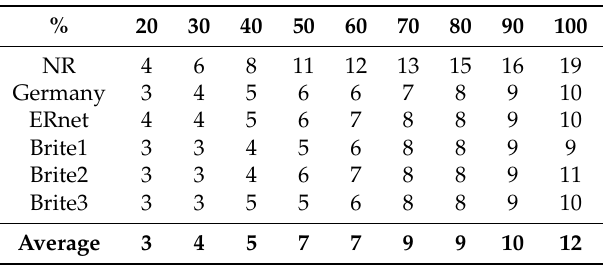
Table 2. Average path costs (averaged across all topologies) achieved by Algorithms 1–4 are